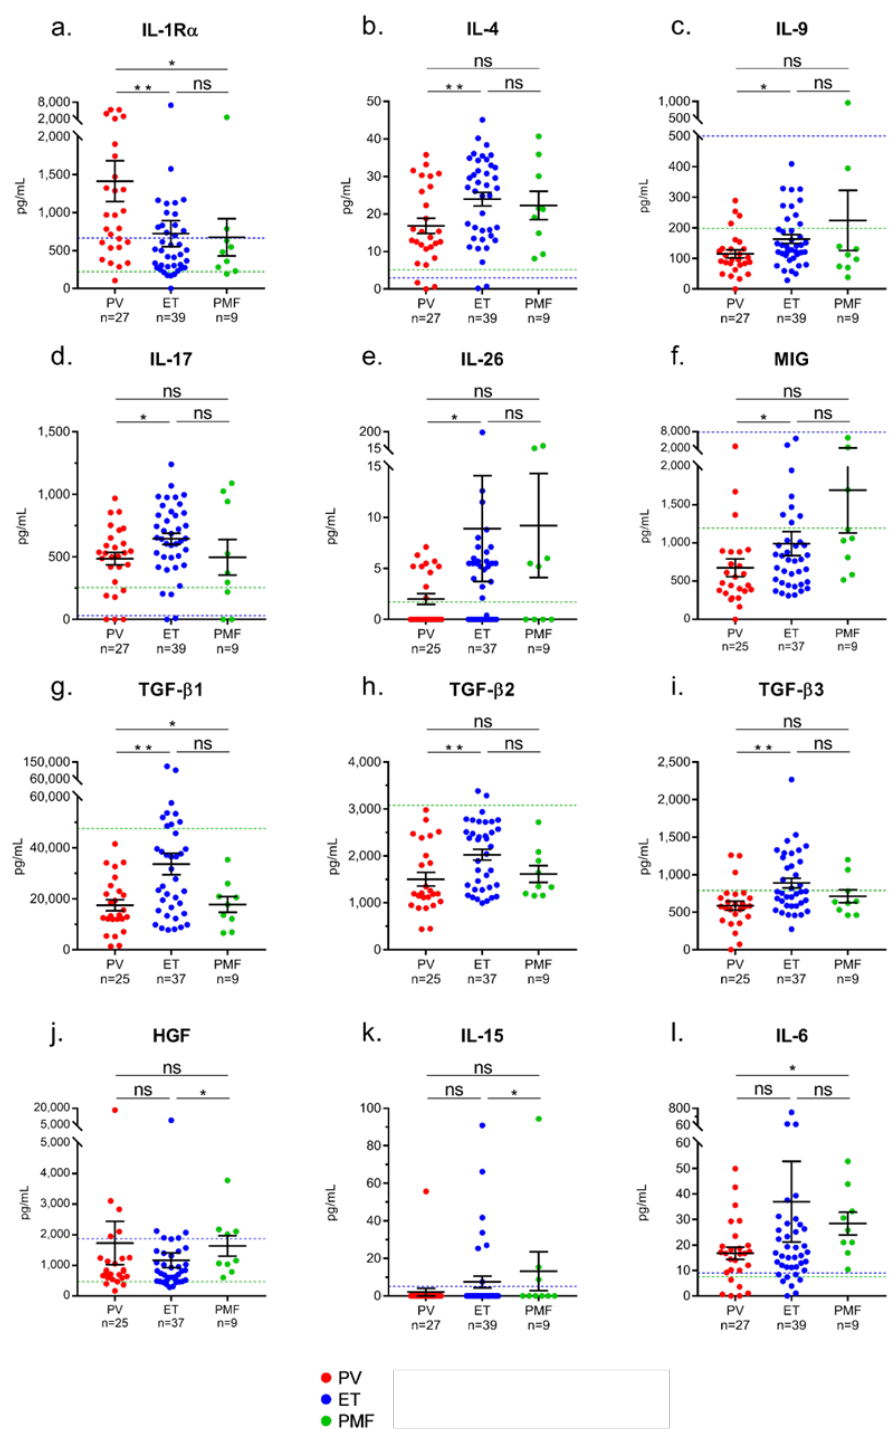
Figure 1. Differences in cytokine levels between PV, ET and primary myelofibrosis (PMF). Significant differences were found between PV, ET or PMF patients in the levels of 12 cytokines: ( a ) IL-1R α ; ( b ) IL-4; ( c ) IL-9; ( d ) IL-17; ( e ) IL-26; ( f ) MIG; ( g ) TGF- β 1 ; ( h ) TGF- β 2 ; ( i ) TGF- β 3 ; ( j ) HGF; ( k ) IL-15; ( l ) IL-6. Results are presented as the means + SEM. NS: not significant. (*) p < 0.05 and (**) p < 0.01, Mann–Whitney t -test. Dotted blue lines represent the upper normal values for healthy individuals according to the manufacturers of the BioPlex Pro-human Cytokine kits, measured in 66 healthy donors. Dotted green lines represent the upper normal values for healthy individuals measured in the 17 healthy donors of our control